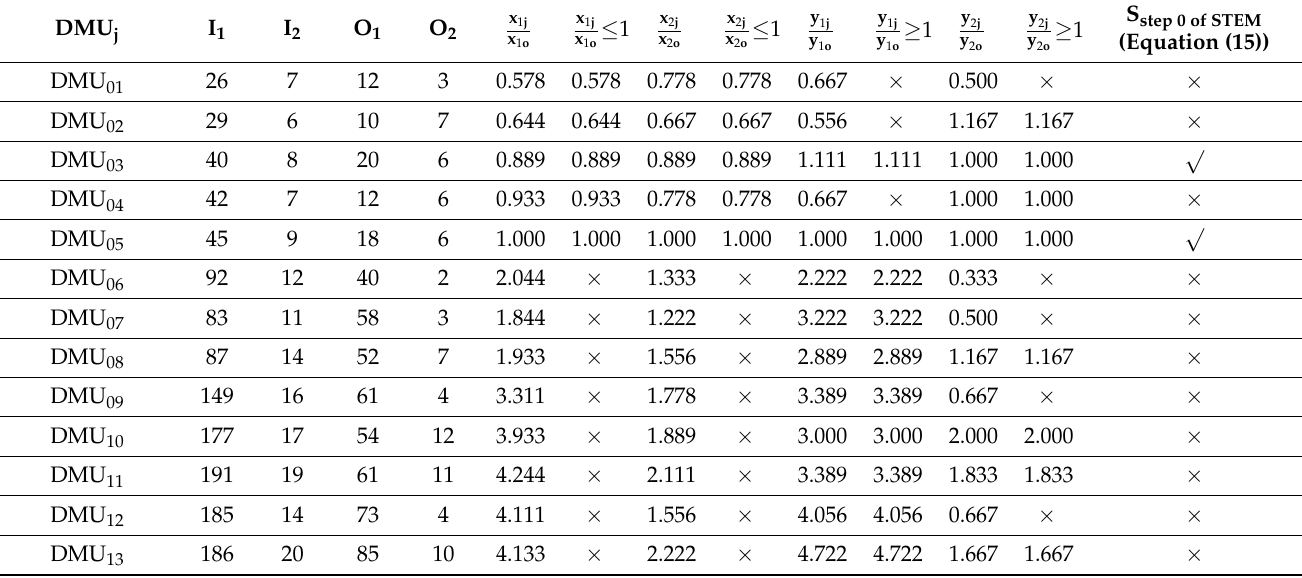
Table 9. Applying the first target finding stage for DMU05 (the first case